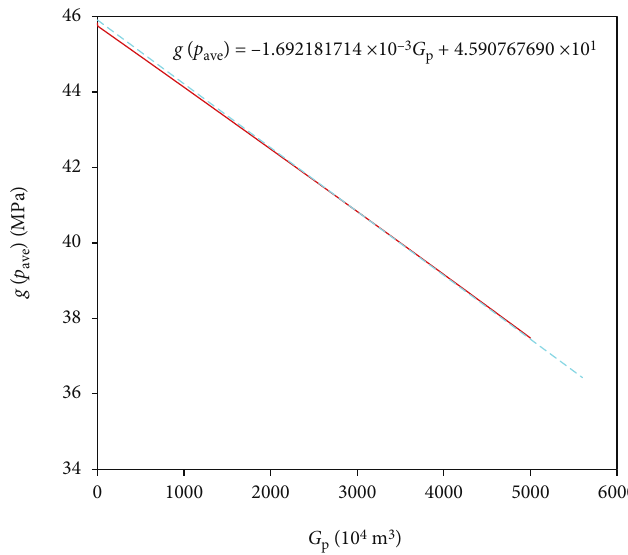
Þ to G for the gas well producing at a constant BHP. p ave